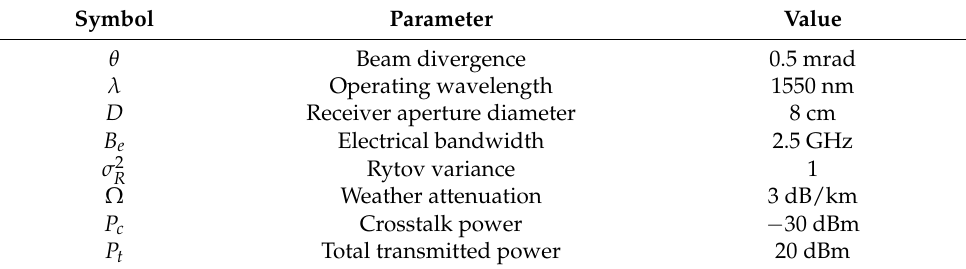
Table 2. Summary of the parameters used for system